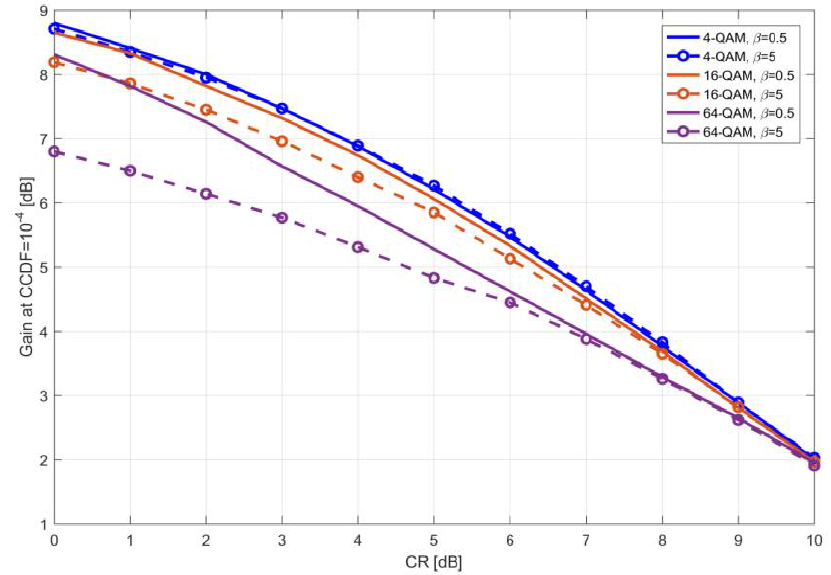
Figure 15. PC-OFDM gain of peak-to-average power ratio (PAPR) at CCDF = 10 −4 dB for different Clipping Ratios. Table 2. CCDF = 10 −4 for the proposed method for β = 0.5 and β = 5 with variable modulation and CRs. Modulation